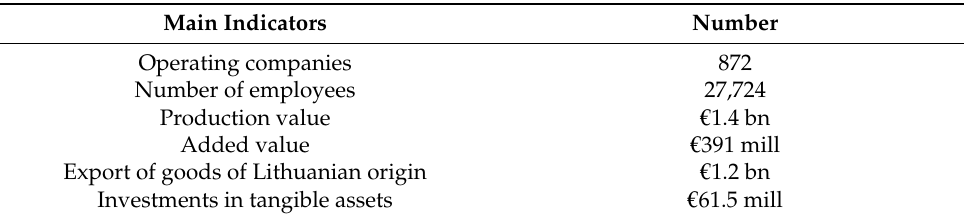
Table 1. Main indicators, 2015